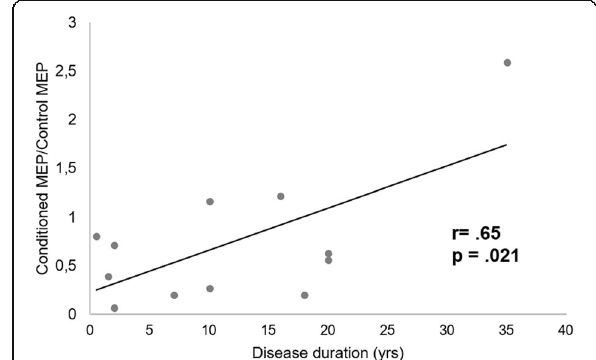
Fig. 2 Correlation between individual extent of long intracortical inhibition (LICI) values (ratio of the average amplitude of the conditioned MEPs to the average amplitude of the unconditioned test MEPs) and disease duration (yrs) in migraine without aura